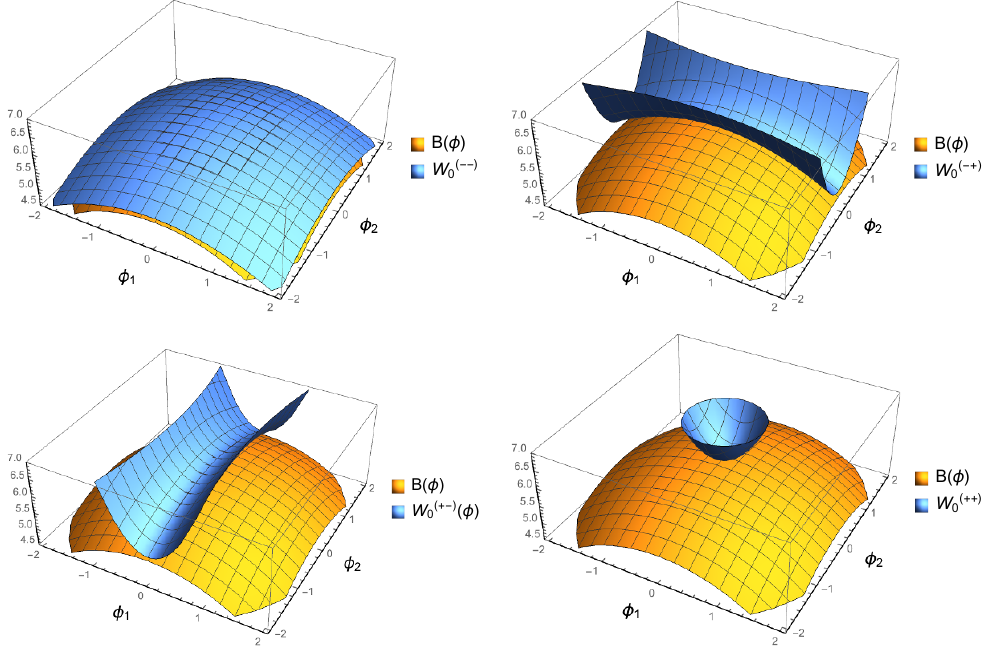
Figure 1 . This (cid:12)gure shows the four leading solutions of the superpotential equation close to a minimum of the potential, of the form (3.13), in the two-(cid:12)eld case. The yellow surface is the critical curve B ( (cid:30)